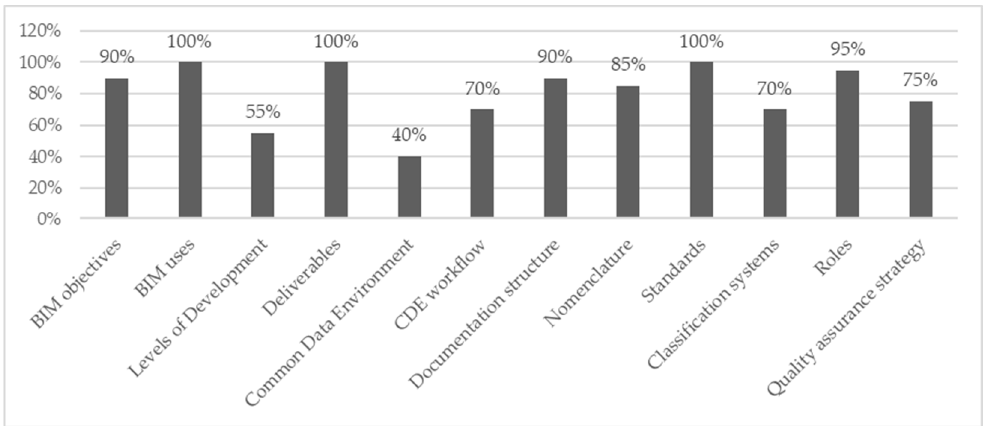
Figure 14. Level of inclusion of BIM requirements in selected tenders.